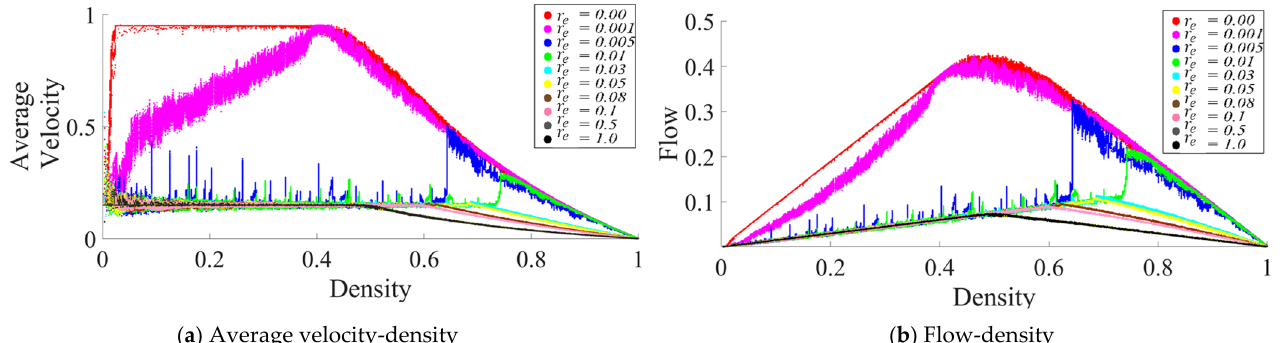
Figure 2. Fundamental diagrams for the ATM simulations with various r e values: ( a ) average velocity ( cells / time step )— density relationship and ( b ) flow ( ants / time step )—density relationship. Variables other than r e were kept constant: L = 1000 cells , σ sat = 80 p units / cell , v min = 0.15 cells / time step , and τ = 1 p units